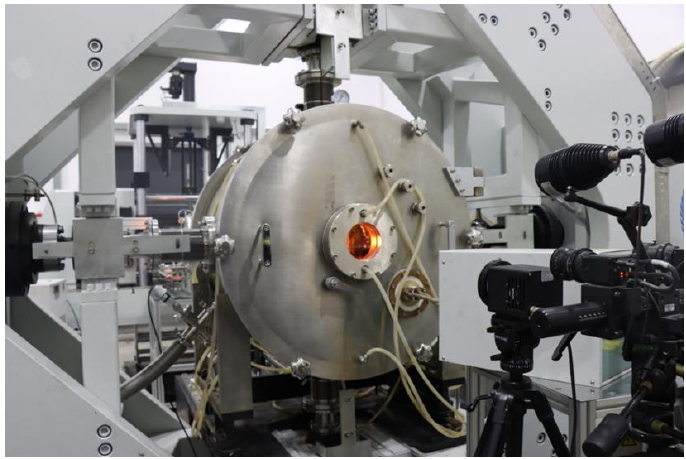
Figure 20. High-temperature tensile composite loading test of C/C composites.